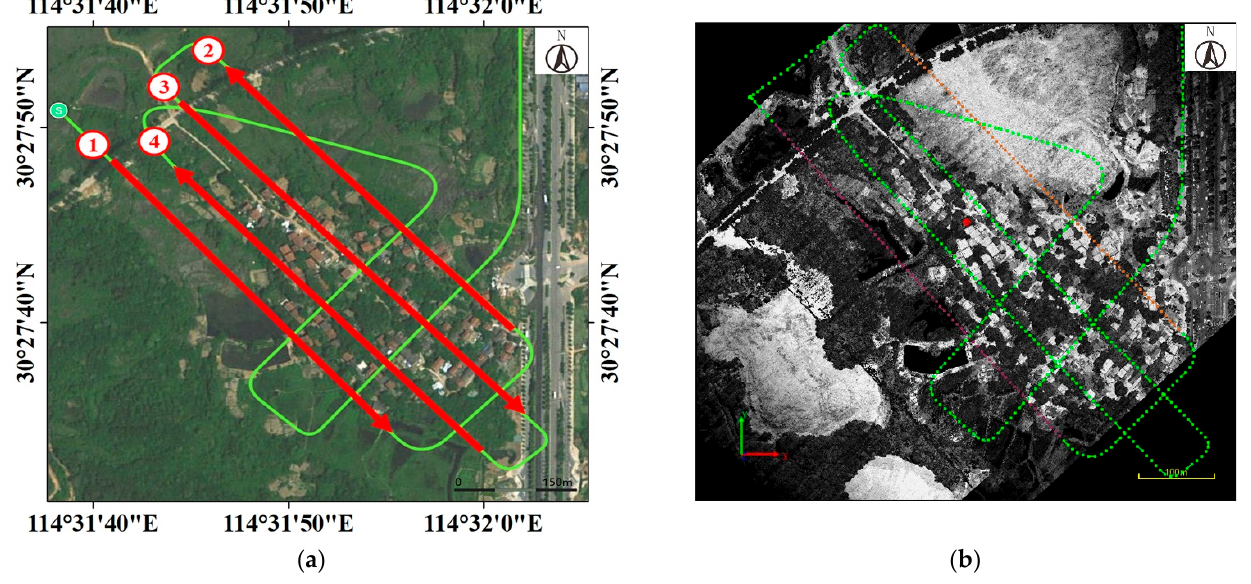
Figure 18. Flight experiment area and flight lines diagram. ( a ) UAV planning route and map view; ( b ) Actual flight path and acquired point cloud.